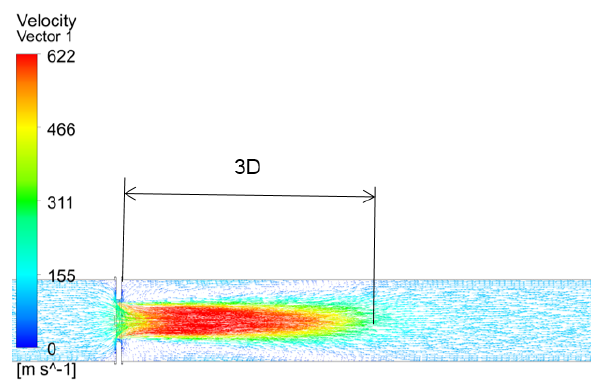
Figure 9: Velocity vectors for a single-hole orifice